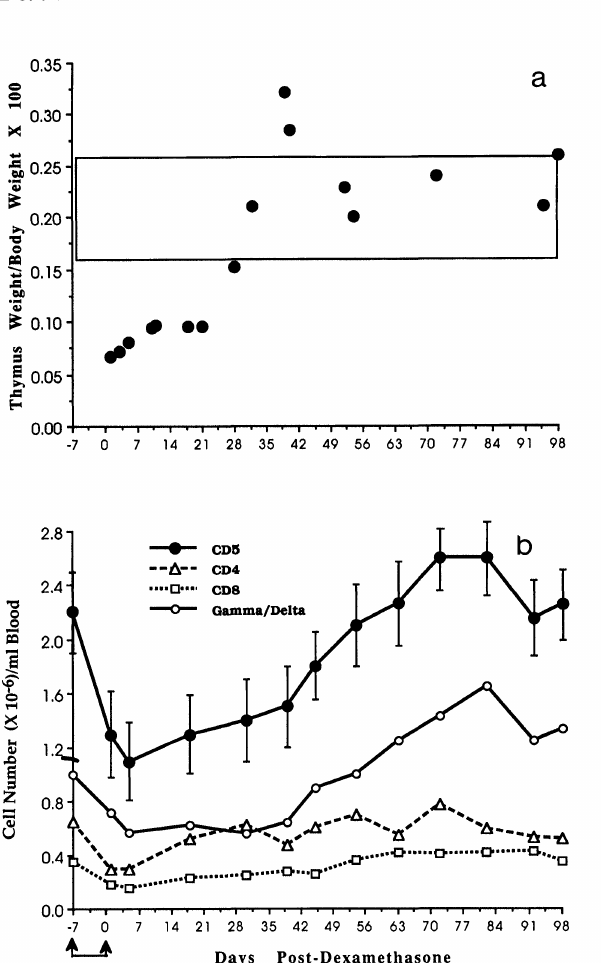
FIGURE 7. Dexamethasone treatment (dex) induced a marked decrease in thymic weight and the number of T lymphocytes in blood, a: Thymic weights were 20-35% of the normal weight immediately after dexamethasone treatment (day 0), but 4-5 weeks later there was a complete recovery of thymic mass. Each data point represents the weight of a single thymus, as a percentage of BW, and the range of normal thymic weights is depicted by the rectangle, b: The total number of T lymphocytes (CD5 hi) and all T-lymphocyte subsets (CD4, CD8, 73 TcR [gamma/delta]) declined markedly following dexamethasone treatment. The total number of T lymphocytes returned to pretreatment levels 8 weeks after dexamethasone treatment with 73 T lymphocytes contributing the most to the T-lymphocyte population. Data presented are the mean + S.D. of values from varying numbers of lambs (days -7 and 0: n 16; day 98: n